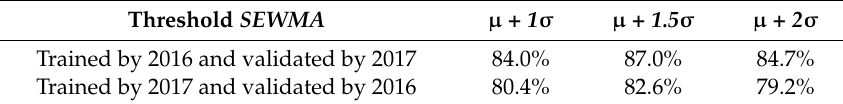
Table 4. Overall accuracies of wheat mapping using the three thresholds tested.